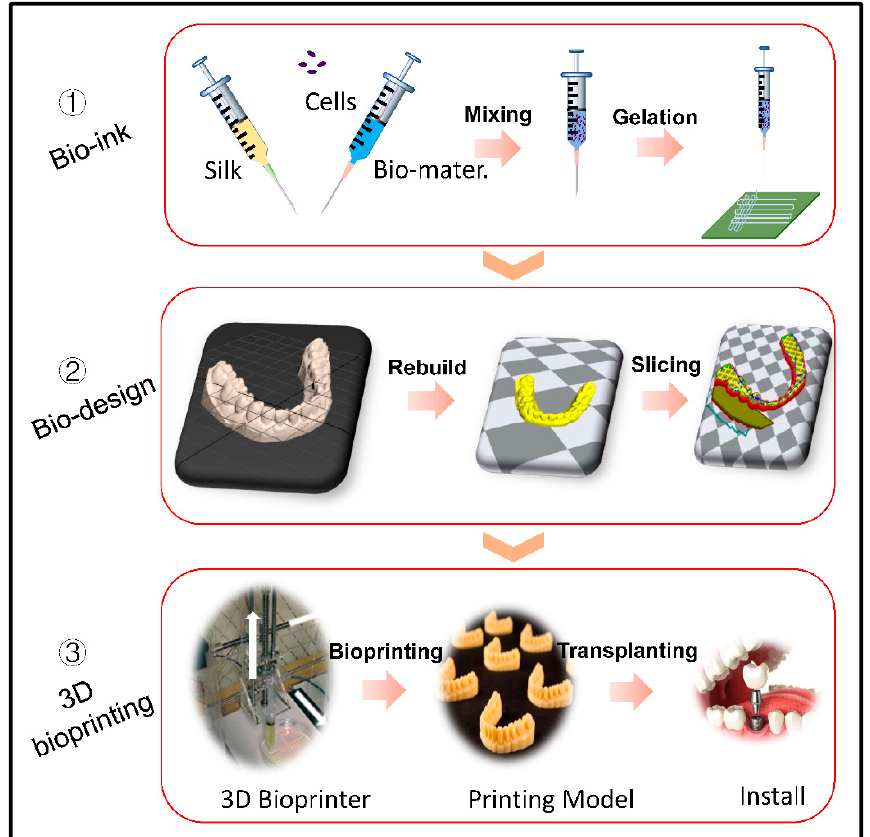
Figure 6. Schematic of 3D printing process. (1) Preparation of SF based bioink for 3D printing (2) Imaging and digital design. (2) 3D printing process and clinical trial. Reproduced with permission from [97]. Copyright 2018, Wiley.